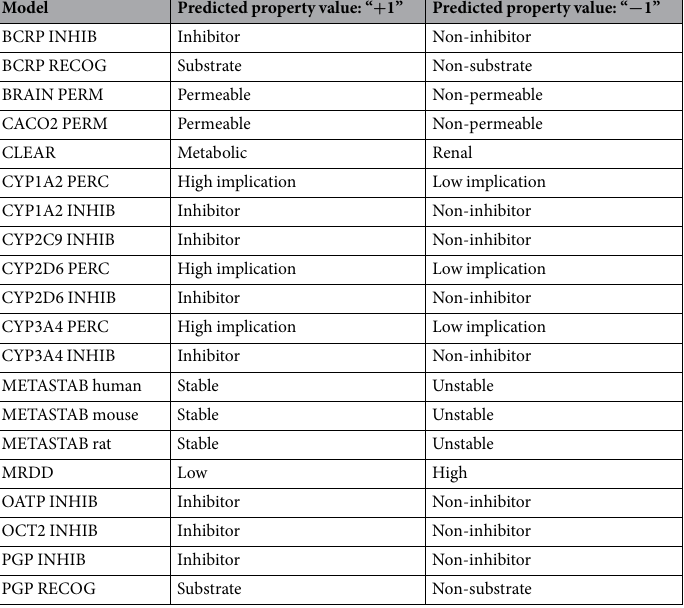
Model Predicted property value: “ + 1” Predicted property value: “ − 1”